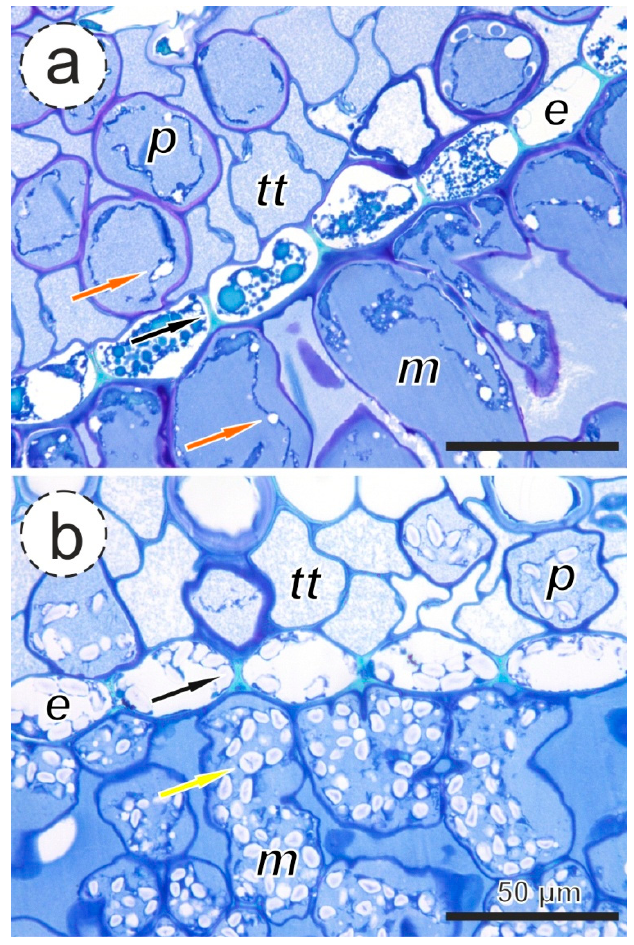
Figure 7. Endodermis and the adjacent tissues of Pinus mugo needles in winter and summer. ( a ) 15 January 2011 and ( b ) 6 July 2011. e, endodermis; m, mesophyll; p, parenchyma cell; tt, transfusion tracheid; black arrows point at the Casparian strips, orange arrows point at translucent droplets, and the yellow arrow points to a starch grain, bar = 50 µm. For orientation, see Figure 1.